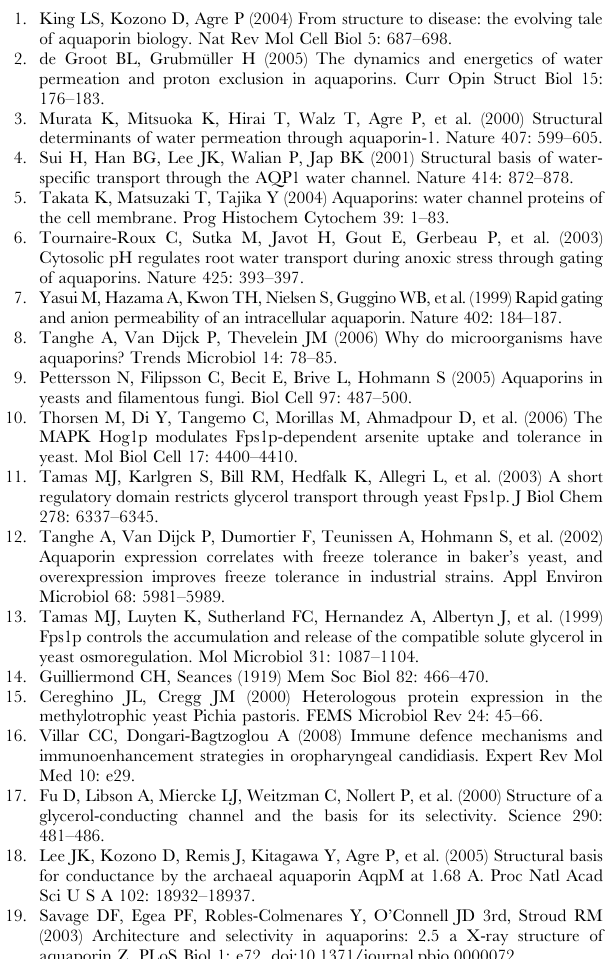
Table S1 Primers used for cloning. Nucleic acid sequences for primers used for creating the AQY1 deficient P. pastoris strain as well as strains overexpressing Aqy1 and mutants of